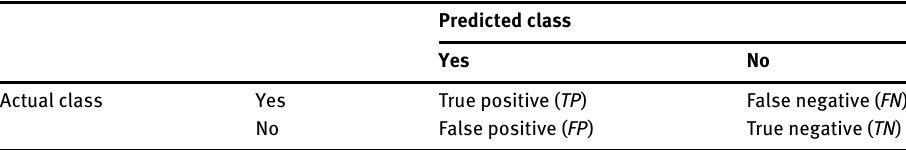
Table 3: Parameter Settings. Parameter Value Population size (no. of grey